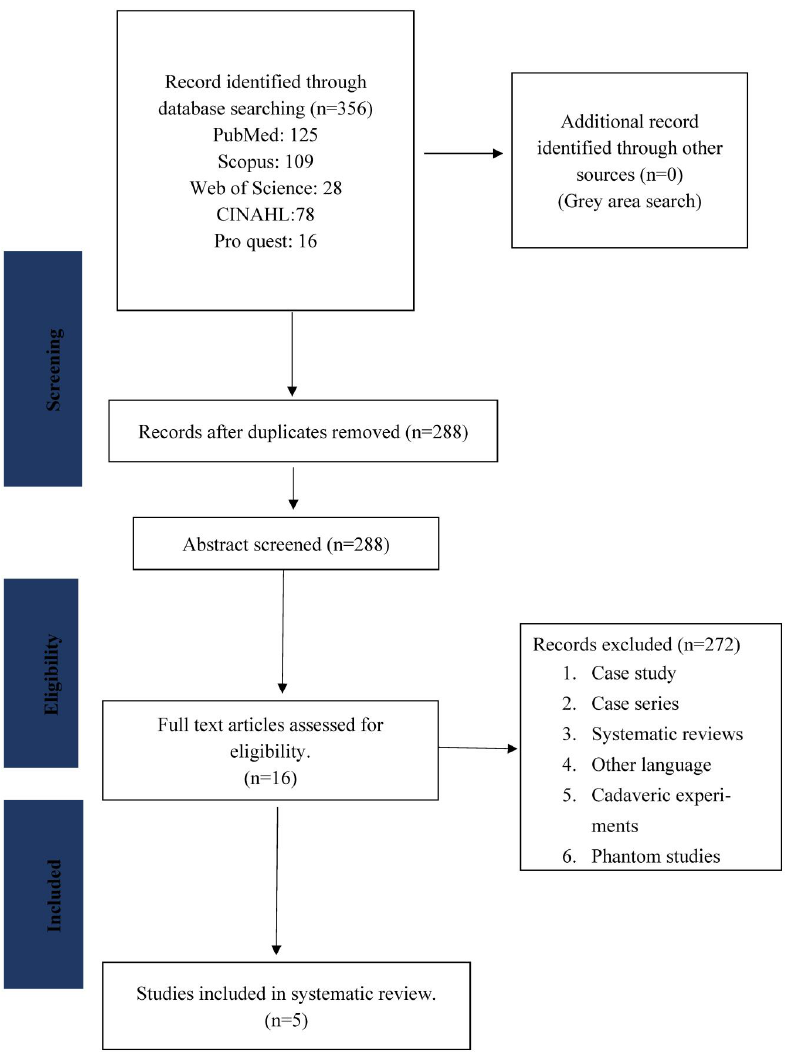
Figure 1. PRISMA Flow-Chart.